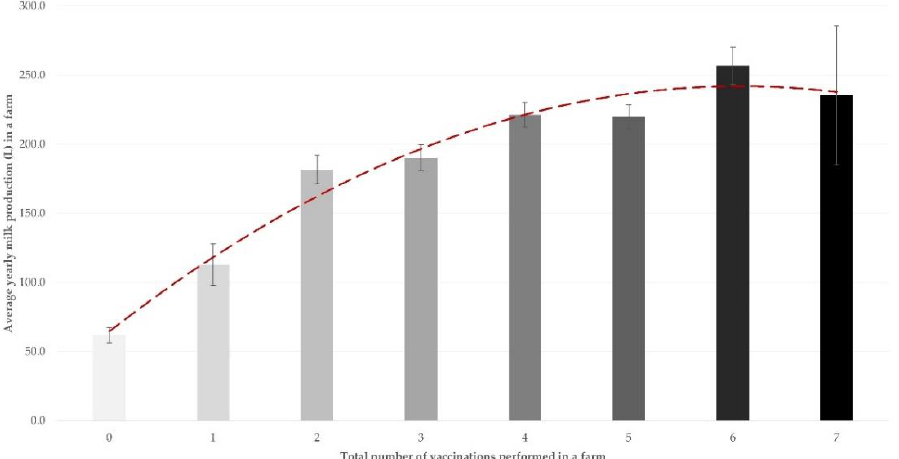
Figure 2. Association between the sum of optional vaccinations performed in a farm and the average milk production per animal, as found in 444 small ruminant farms in Greece (bars show standard error of the mean, red dashed line is respective trendline).